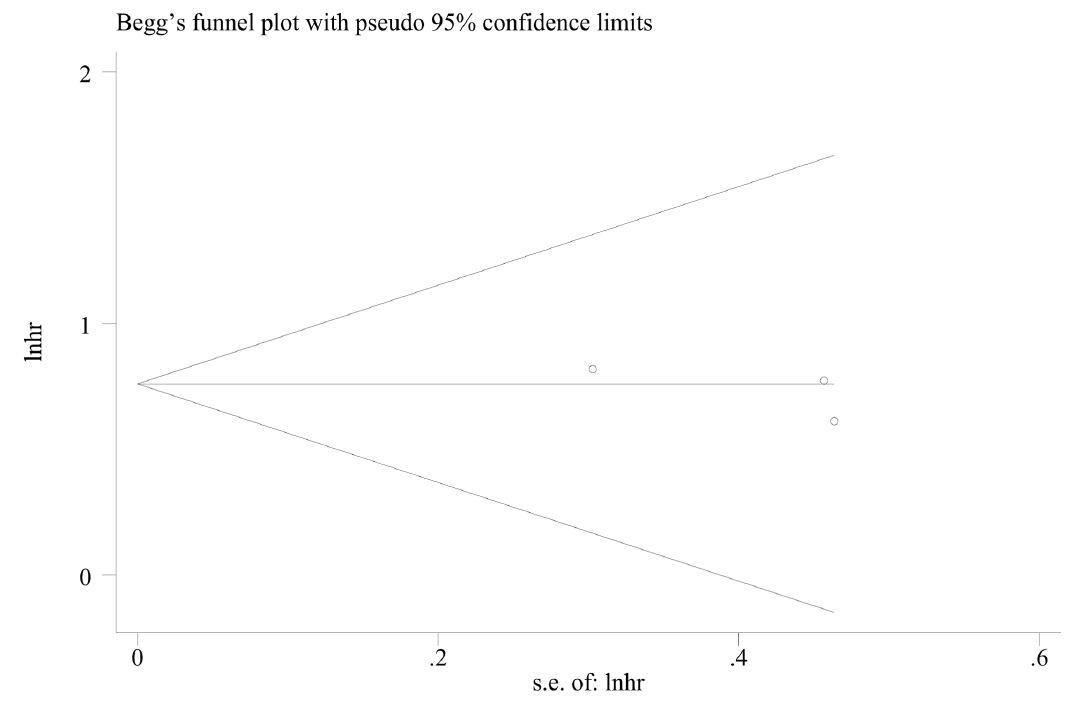
Figure 5. Funnel plot for hazard ratios of recessive model in DFS studies.